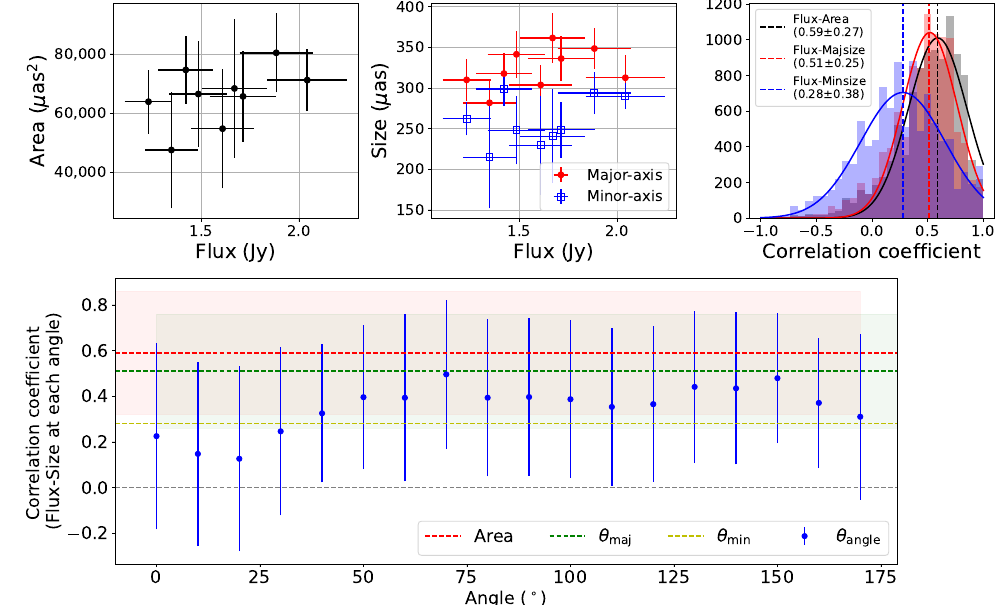
Figure 6. ( Top ): The correlation of flux density and area (i.e., πθ maj θ min /4; left ), θ maj ( middle , red), θ min ( middle , blue) from our observations in 2019, where the θ maj and θ min are the major-axis and minor-axis size, respectively. Resampling distributions of the estimated correlation coefficients of each are also shown ( right ). ( Bottom ): The correlation coefficients between flux density and size at each angle (east of north; with a step of 10 ◦ ). No significant correlation is found that is larger than the ones from area and major-axis